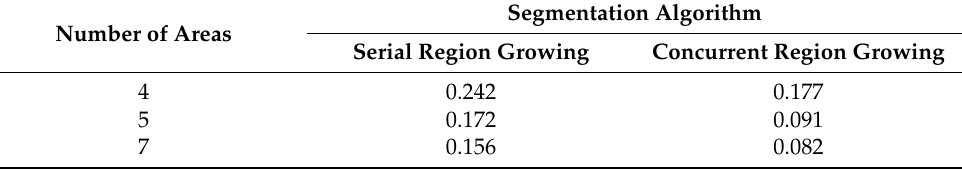
Table 10. Zeboudj’s contrast for 4, 5, 7 regions (Serial Region Growing, Concurrent Region Growing), UVG video